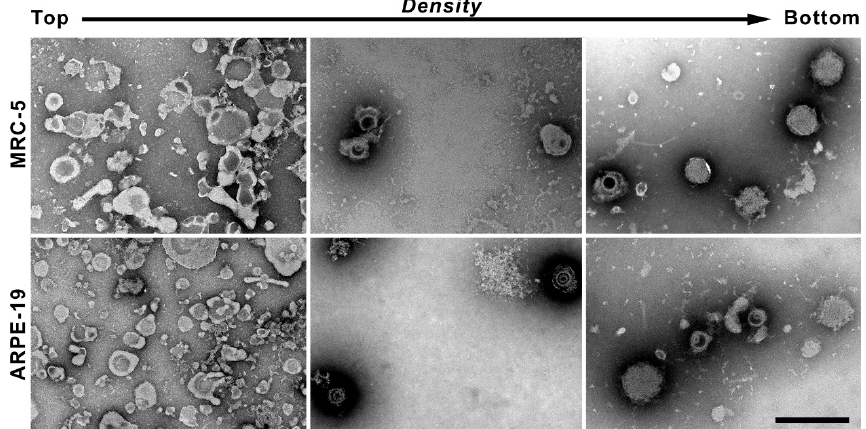
Figure 6. Electron microscopy of samples collected from glycerol-tartrate gradients. Representative images of each of the three parts of the gradients: top ( left panel ), middle ( central panel ) and bottom ( right panel ); indicating the main components isolated in each section in both MRC-5 and ARPE-19 cells. The top fraction was mainly integrated by cell membranes; the intermediate part was formed mostly by virions while DB mainly formed the bottom section.